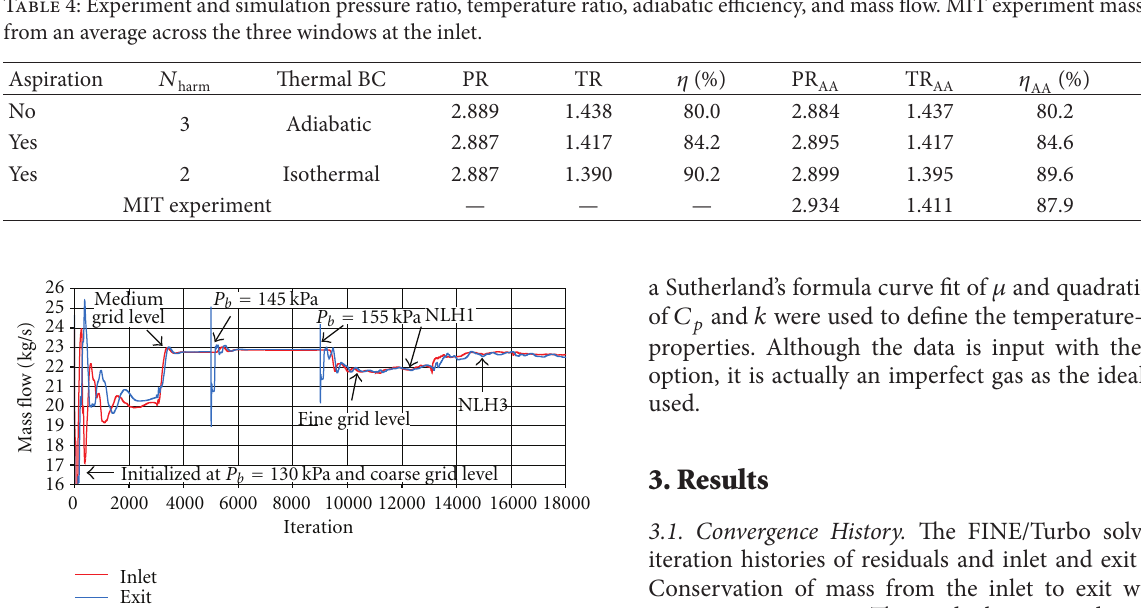
F 9: Example convergence history (adiabatic 100